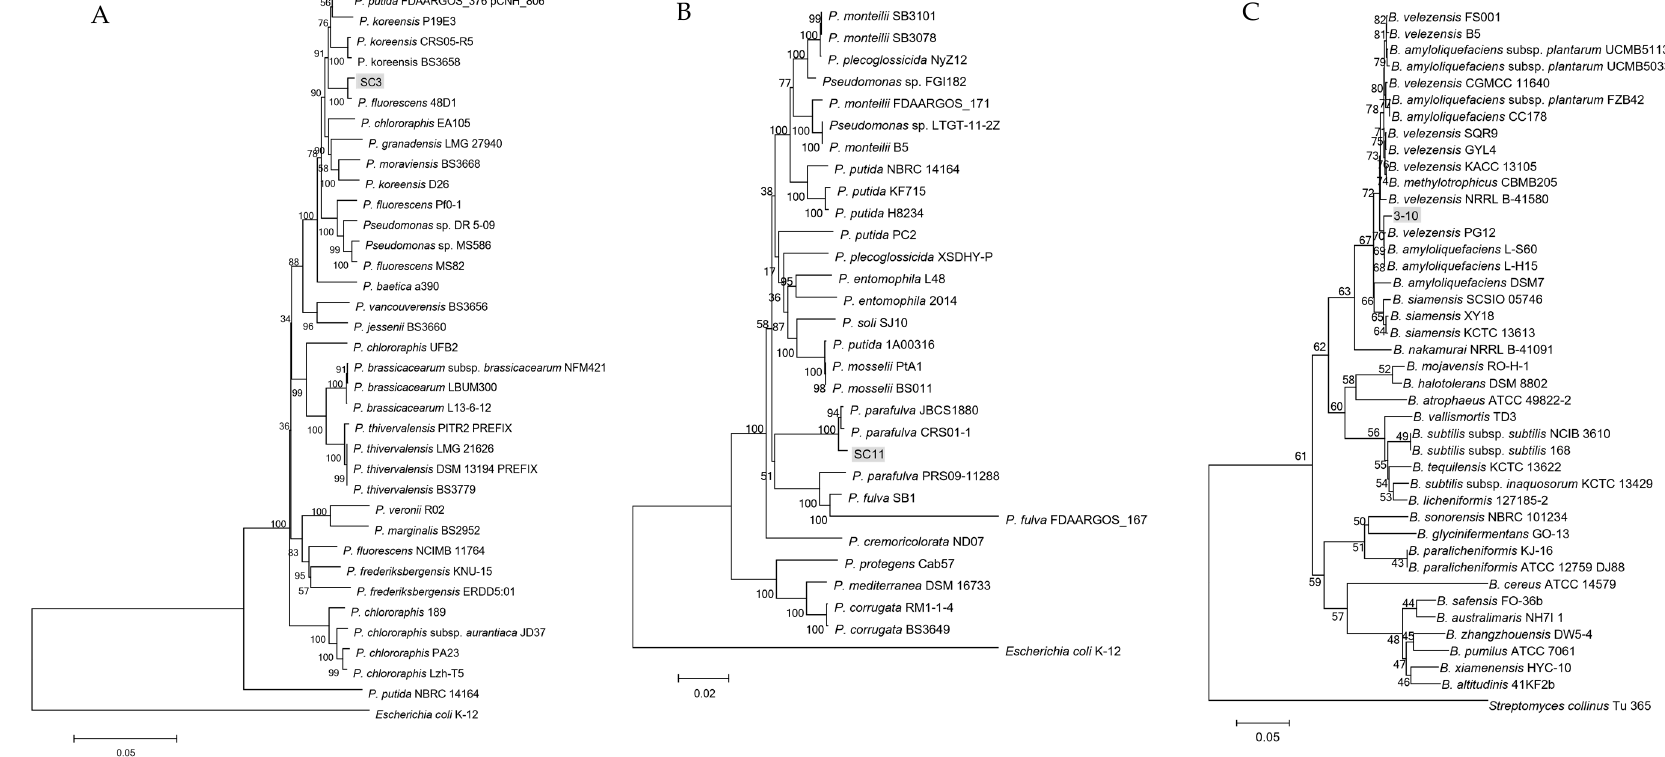
Figure 2. Joint phylogenetic trees based on the concatenated nucleotide sequences of the 16S rRNA, gyrB , rpoB and rpoD genes of strains SC3 ( A ), SC11 ( B ), and the 16S rRNA, gyrA and gyr B genes of strain 3-10 ( C ). Consensus sequences of every gene from related strains were aligned with ClustalW and trimmed in the same sizes. All the sequences from the same strain were assembled to construct a joint neighbor-joining tree. Bootstrap values after 1000 replicates are expressed as percentages. Scale bar denotes nucleotide substitutions per site.